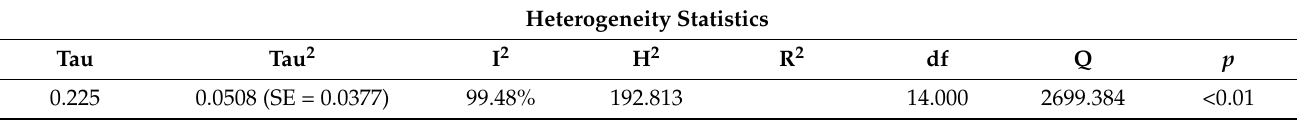
Table 6. Splenic artery prevalence data heterogeneity of the included studies. Heterogeneity